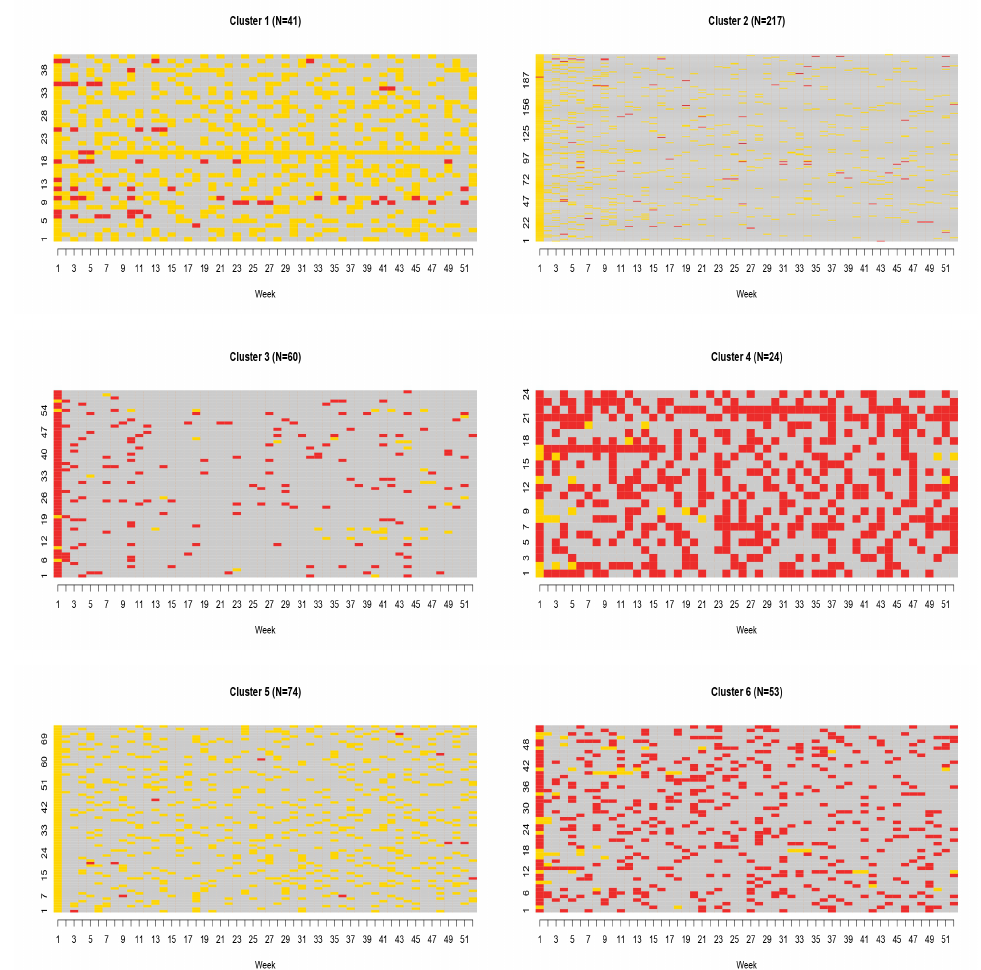
Figure 2. Index plots for weekly regimen use during the first year of opioid